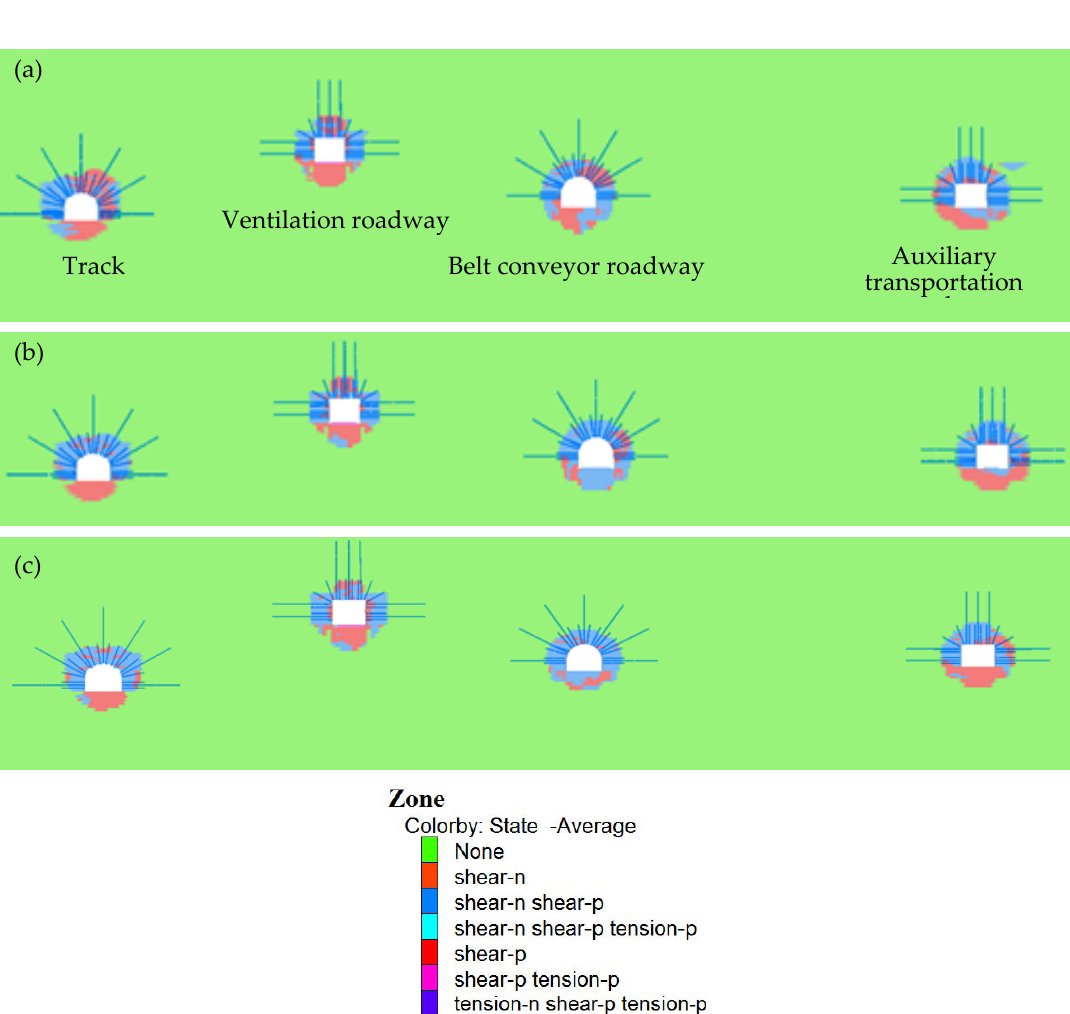
Figure 15. Maximum vertical displacement at different positions of working face and roadway: ( a ) the track roadway and ( b ) the auxiliary transportation roadway.